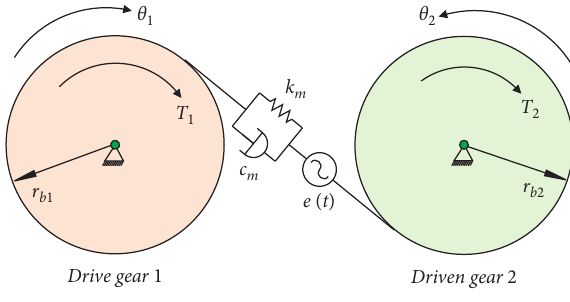
Figure 3: Dynamic model of meshing gear